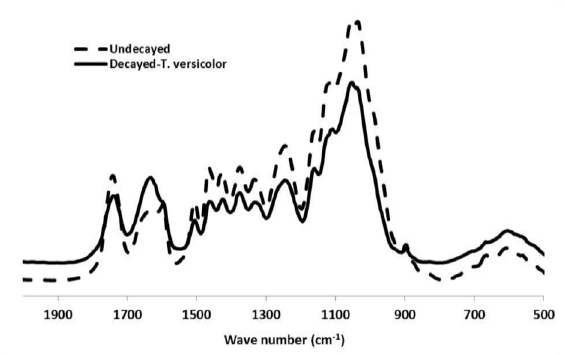
Figure 3 - FT-IR spectra of hornbeam wood naturally infected by Trametes versicolor ( in vivo